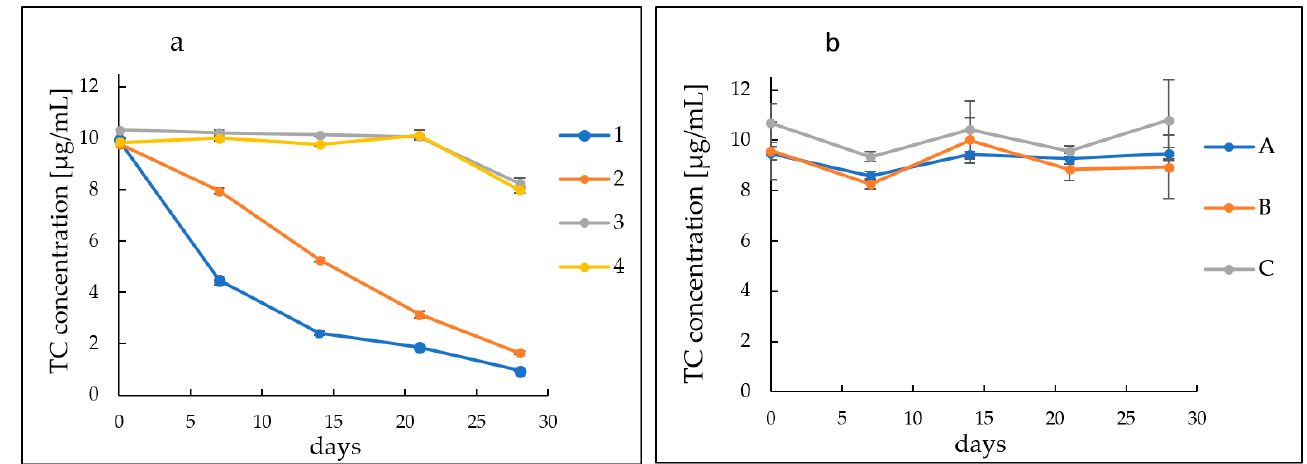
Figure 1. Course of TC concentration changes in hydrogels. ( a ) Formulations (1–4) with variable polymer content and ( b ) formulations (A–C) with variable polymer type.